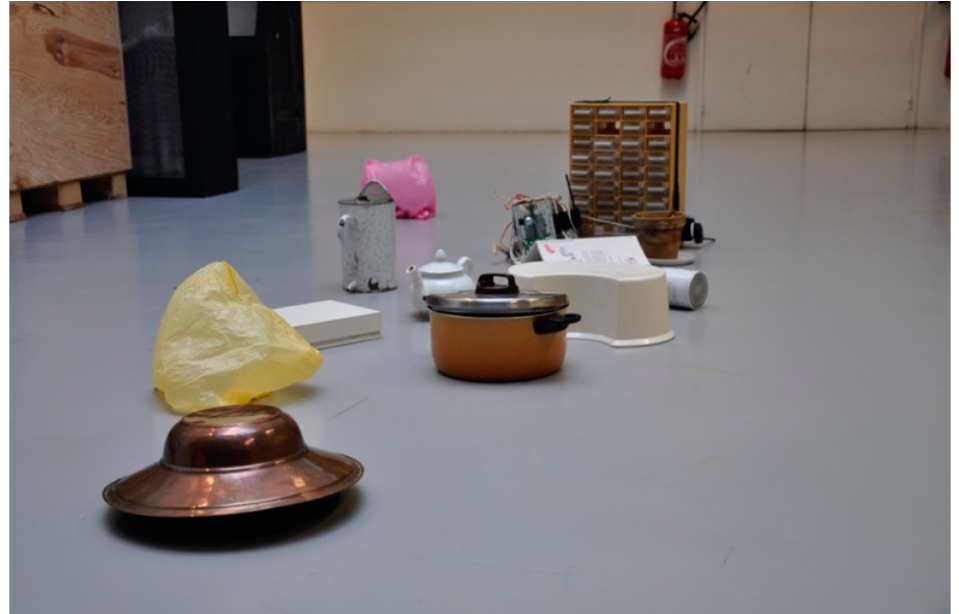
Figure 3. L’Assemblée des Objets , GOR, La Gaîté Lyrique, Paris, 2017. Figure 3. L’Assembl é e des Objets , GOR, La Gaît é Lyrique, Paris, 2017. Scattered in a room, worn, and broken objects are animated by sudden and repetitive movements. Several pots and pans clatter their lids, a large metal ventilation pipe vibrates on the floor, a vacuum cleaner filter and a lampshade continuously moves back and forth, while wooden boxes and a toilet paper holder strikes its flaps in a similar continuous manner. L’ Assembl é e des Objets is initially perceived as a chaotic space. Prior to